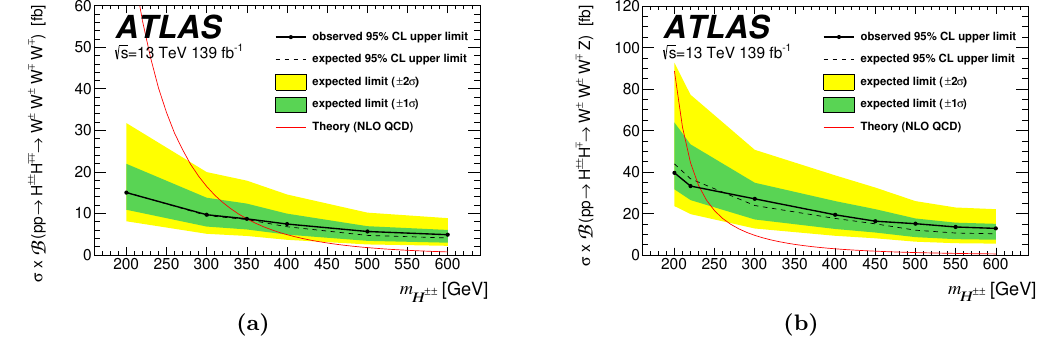
Figure 9 . Observed and expected upper limits on the (a) H ±± pair production and (b) H ±± and H ± associated production cross section times branching fraction at 95% CL obtained from the combination of 2 ‘ sc , 3 ‘ and 4 ‘ channels. The region above the observed limit is excluded by the measurement. The bands represent the expected exclusion curves within one and two standard deviations. The theoretical prediction [29] including the NLO QCD corrections [52] is also